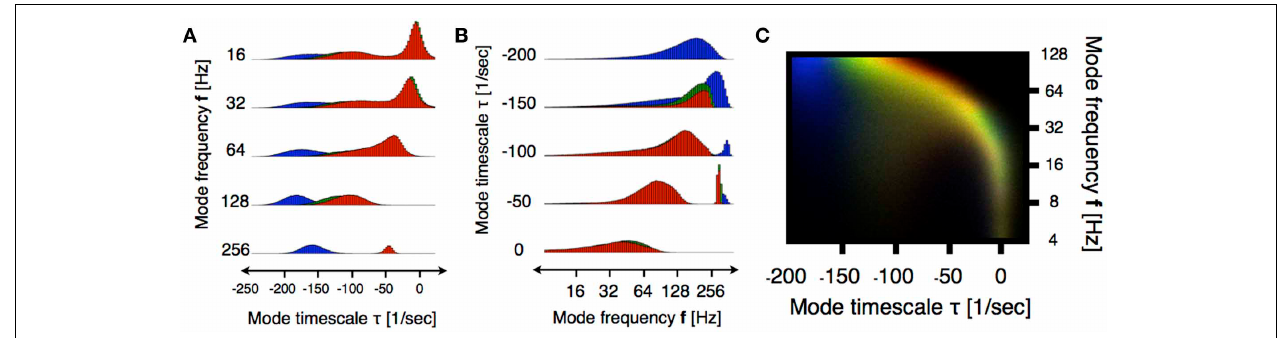
FIGURE 4 | Detailed view of eigenmodes distributions for subject 1. Colors indicate the segments indicated in Figure 1A . (A) Histogram in Figure 3A is sliced by restricting the analysis to frequency bands of 5Hz centered around the indicated values. Note that the blue histograms are always to the left of the red ones indicating increased stability as anesthesia is induced. (B) Same analysis as (A) restricted to slices of 50 1 s . Note the emergence of highly damped high frequency oscillations in the anesthetized